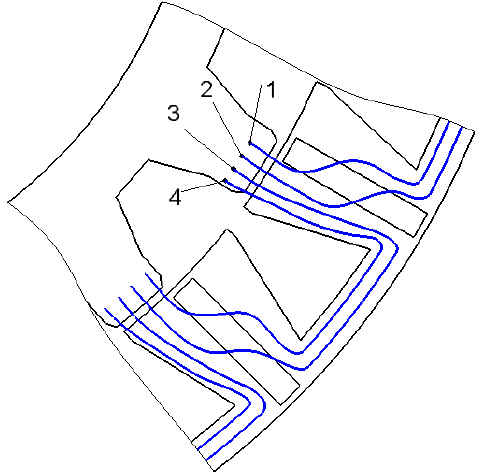
Figure 8. Flux flow in a flux-switching machine (FSM).